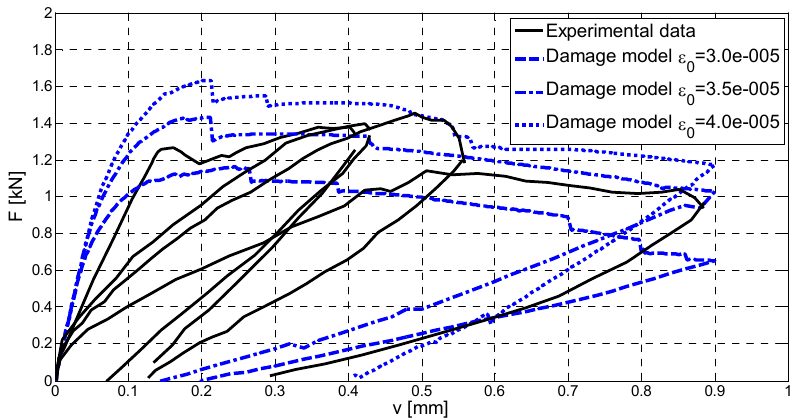
Figure 4: Response of the masonry arch: comparison between the experimental result data and numerical results obtained for different  values of the 0